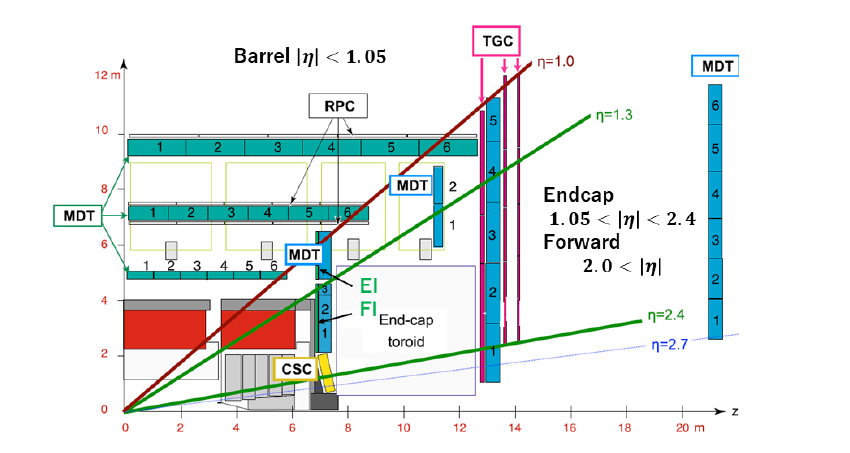
Figure 1. Schematic drawing of one quarter cross-section of the muon system of the ATLAS detec- tor